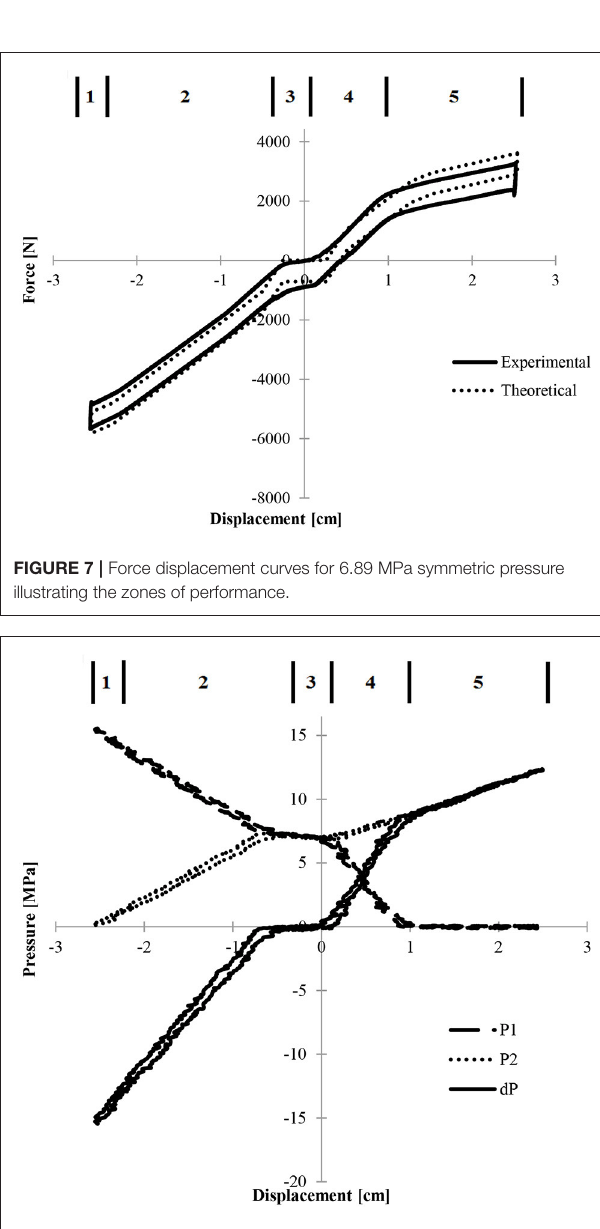
FIGURE 8 | Pressure versus displacement curves in chambers 1 and 2 (P1 and P2, respectively) and the corresponding pressure differential, dP showing the multi-linear zones of the device.